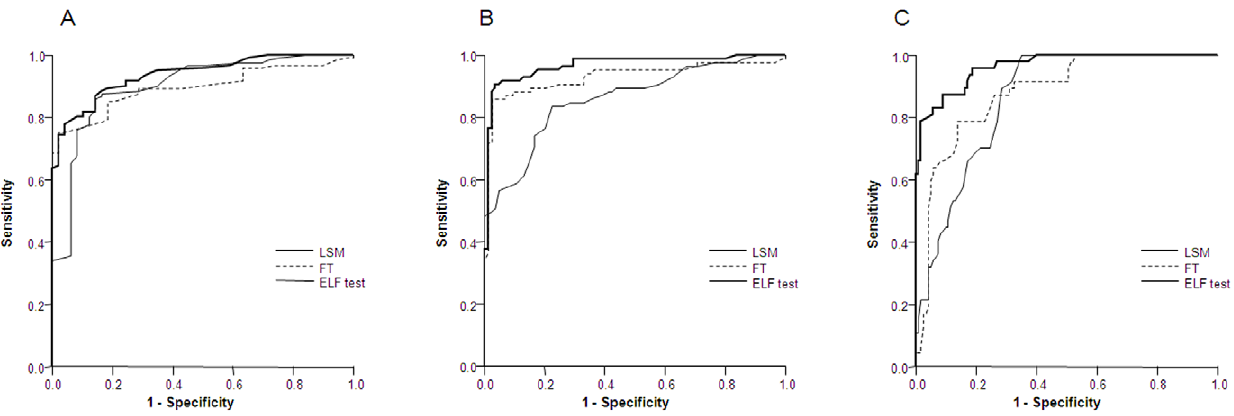
Figure 3. Receiver operating characteristic (ROC) curves for ELF test, LSM and FT in the diagnosis of significant fibrosis ( $ F2, A), advanced fibrosis ( $ F3, B), and cirrhosis (F=4, C).